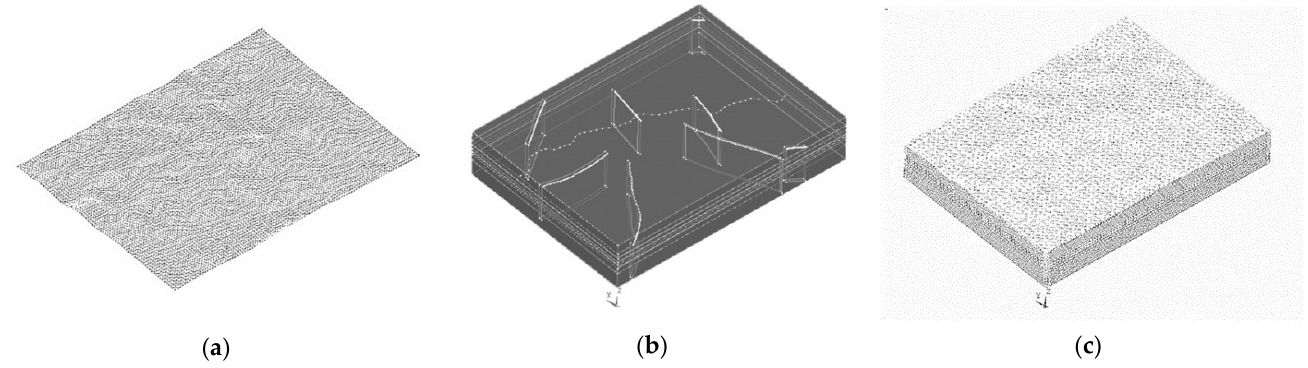
Figure A4. The finite-difference model of the head area of the Three Gorges Reservoir: ( a ) free surface, ( b ) geometry model of fault zone and block, and ( c ) mesh division. Table A1. Underground stratification and lithology related parameters, Adapted with permission from Ref. [30]. 2020, Journal of Geodesy and Geodynamics.